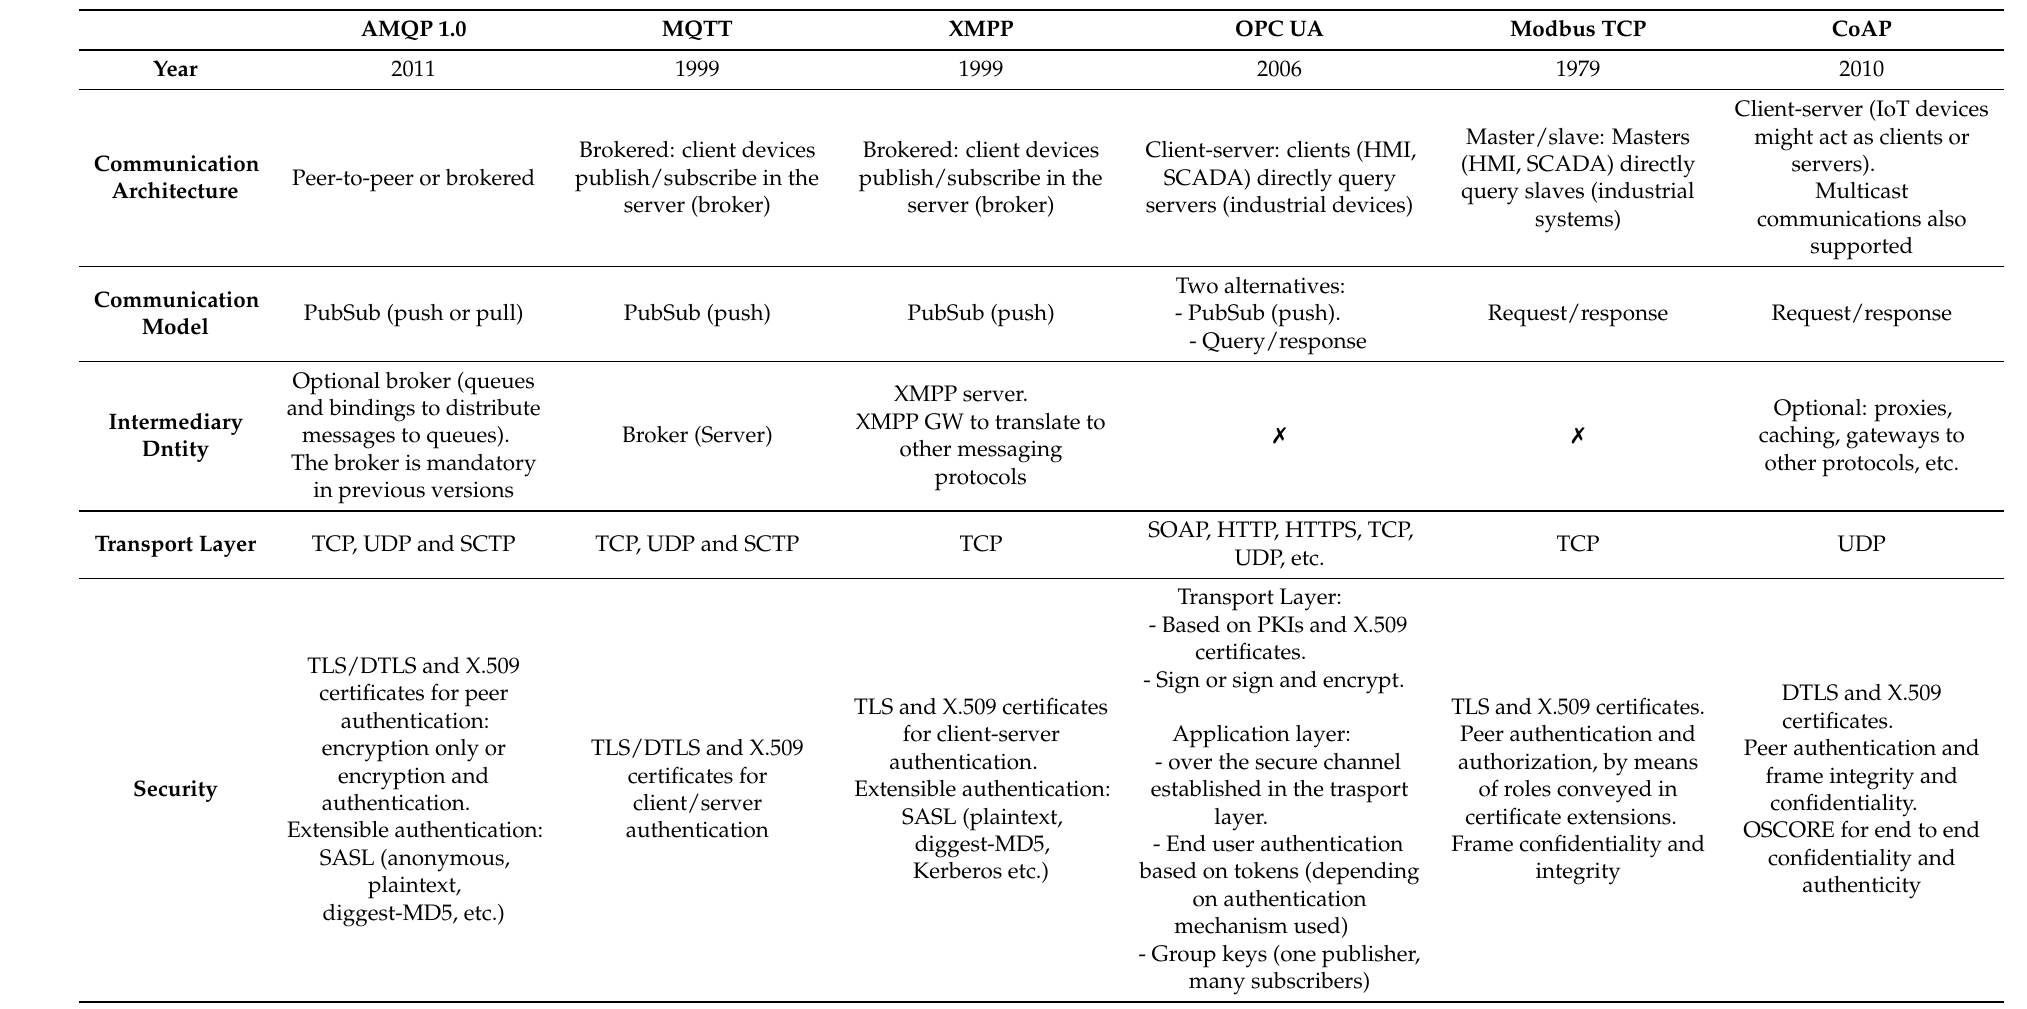
Table 1. Summary of industrial communication